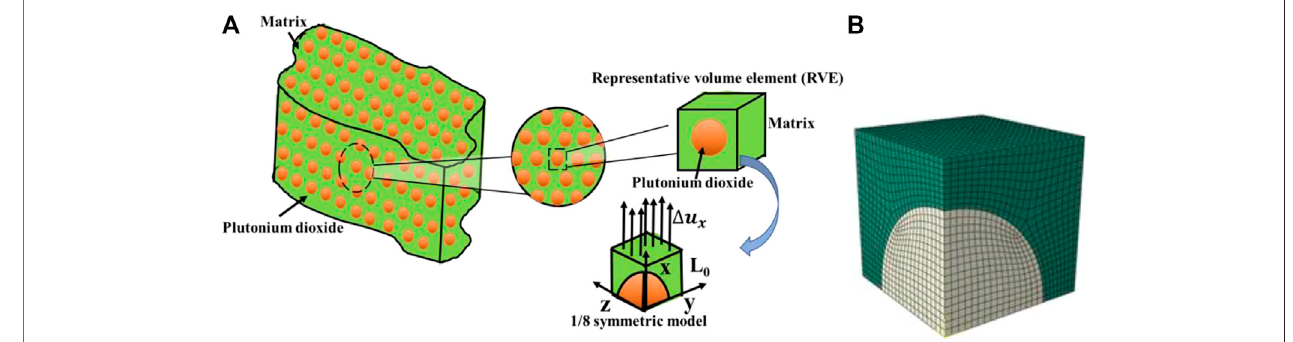
FIGURE 1 | (A) Development of a fi nite element model and (B) mesh